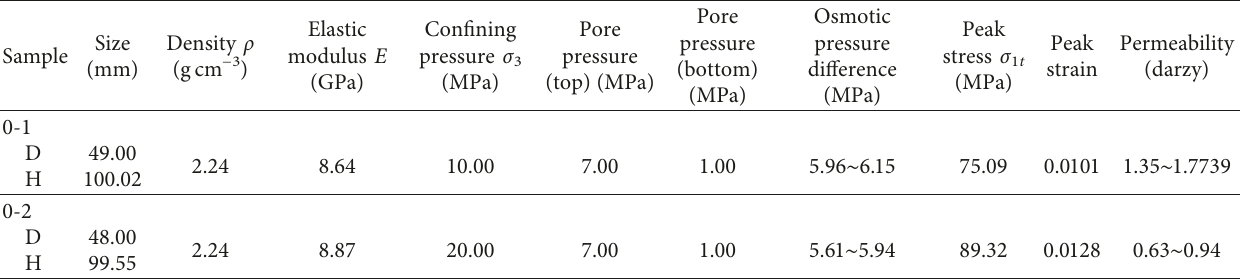
Table 3: Seepage test results of intact sandstone.